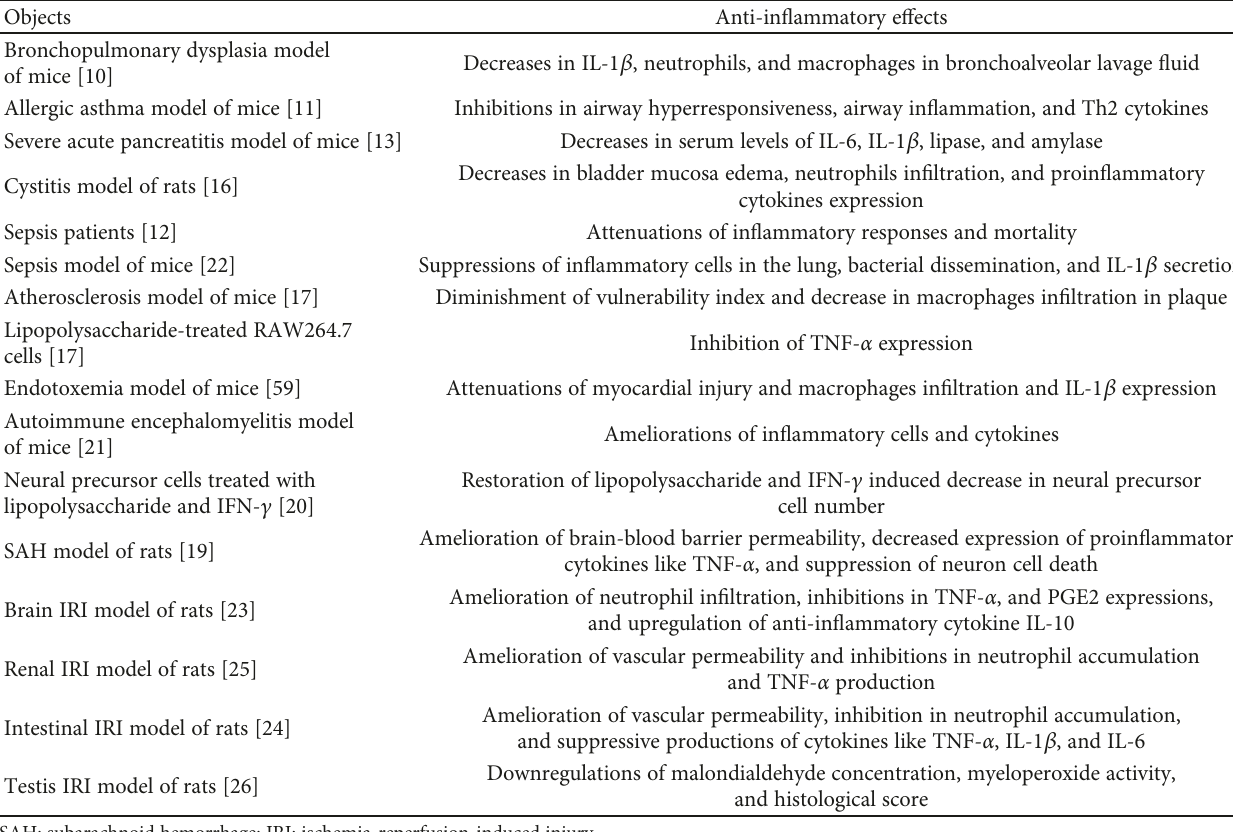
Table 1: The anti-in fl ammatory e ff ects of glibenclamide in previous